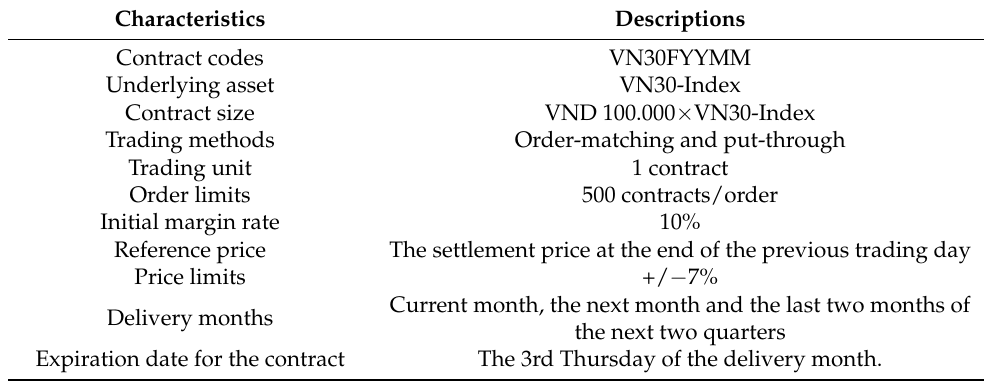
Table 2. VN30-Index futures contract